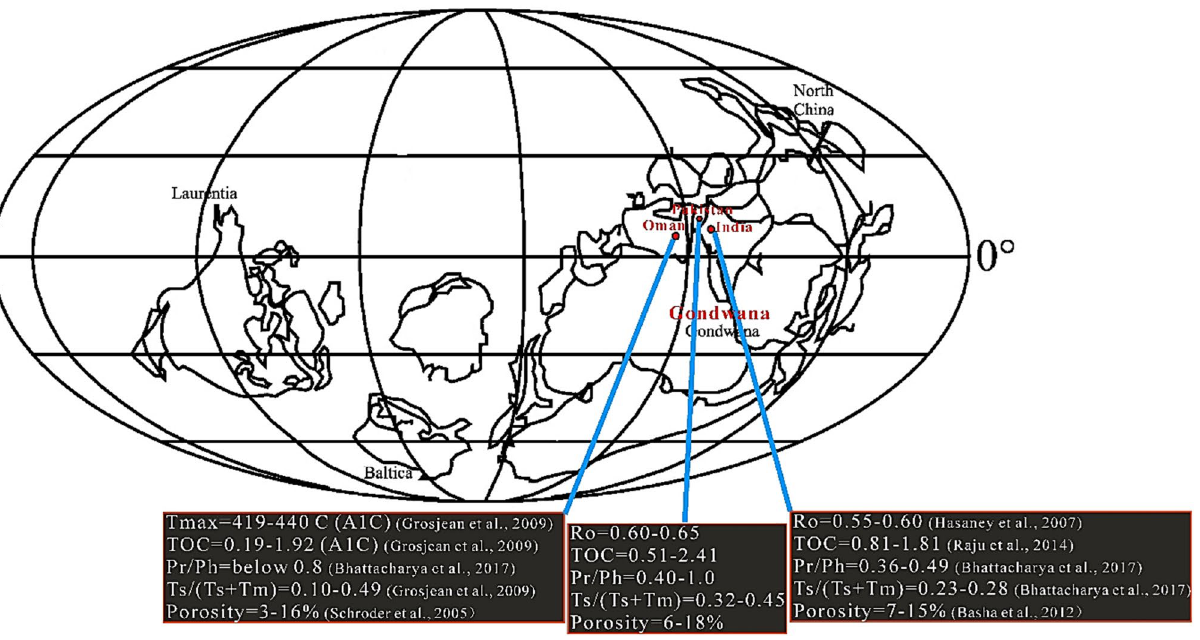
Figure 18. Distribution of various source and reservoir rock properties along with certain biomarker parameters in the Infracambrian rock sequence from SE Pakistan, India, and southern Oman. CorelDRAW X5 was used to create the illustration (www. corel draw.